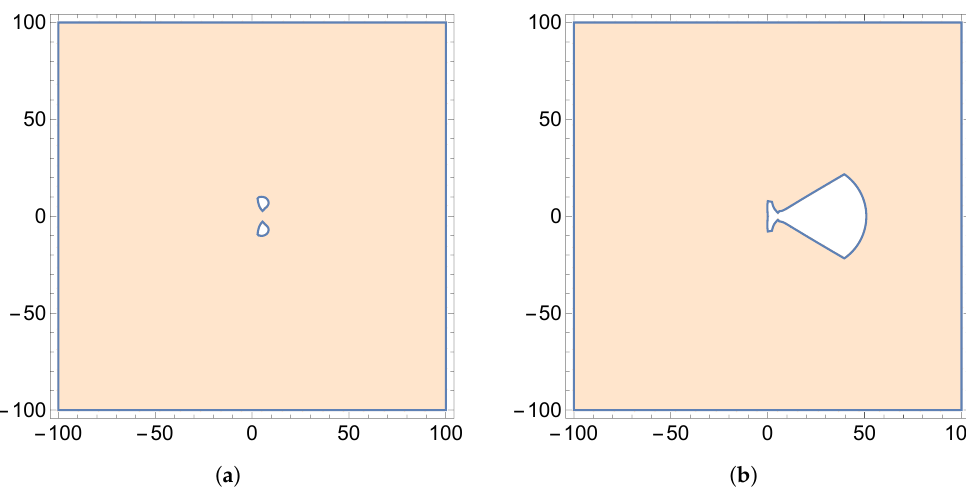
Figure 2. Stability regions for the overlapping hybrid block method. ( a ) Equally spaced intra- step points. ( b ) Optimal intra-step